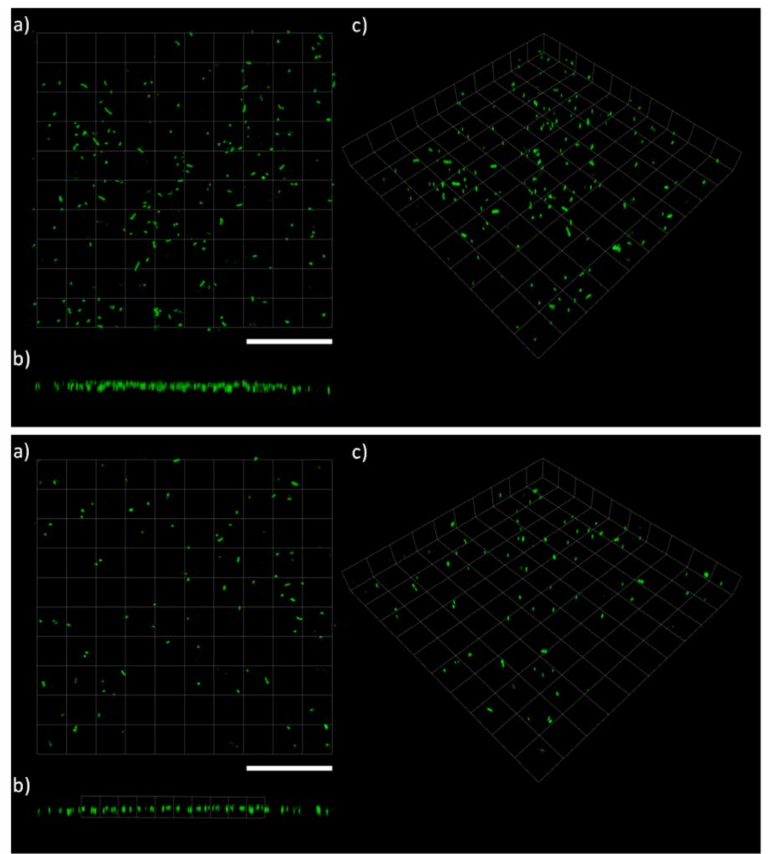
Figure 4. CLSM microscopy on LIVE/DEAD stained C. marina on the coated surfaced at the end-point (48 h), where ( Top ): JUG + PMMA + ROS, ( Bottom ): JUG + PMMA and ( a ) top view, ( b ) side view and ( c ) 3D view. Scale bars = 112 µ m. JUG = juglone, PMMA = poly(methyl methacrylate), ROS =